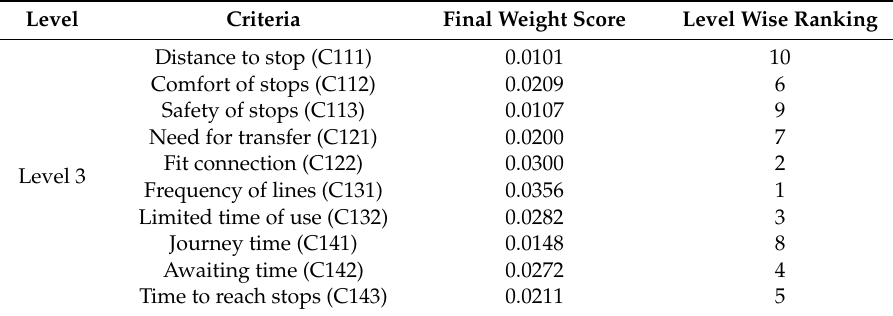
Table 6. Priority ranking for level